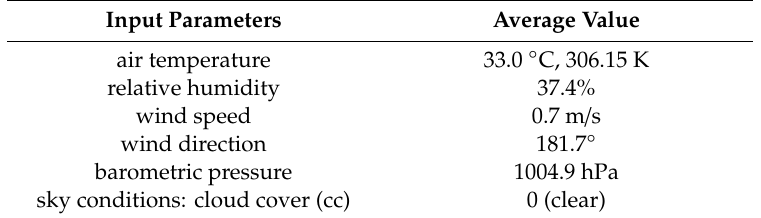
Table 4. Simulation inputs detected in situ for the hottest day of 2016 (30